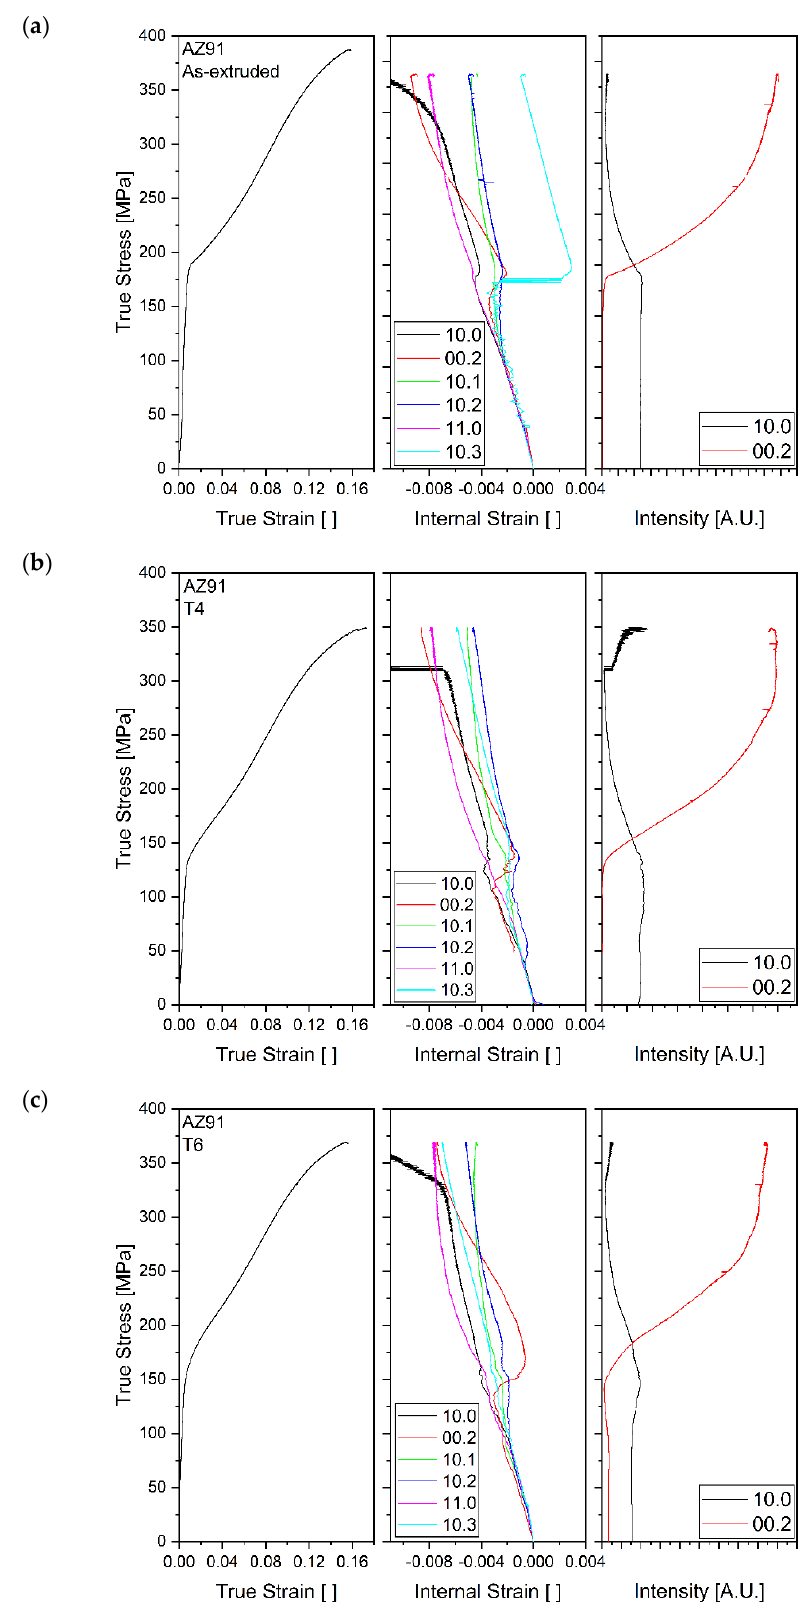
Figure 3. Plots showing macroscopic true strain (left), strain on lattice planes (centre), and intensity (right) against true stress for ( a ) AZ91 as extruded; ( b ) AZ91 T4; ( c ) AZ91 T6.